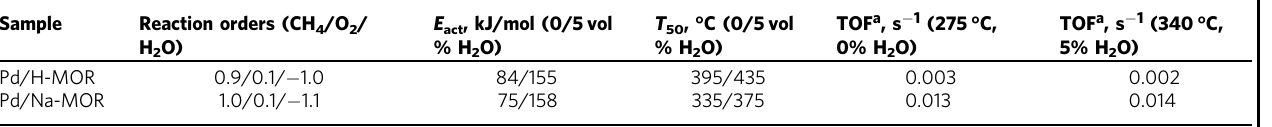
Table 2 Kinetic analysis of Pd/H-MOR and